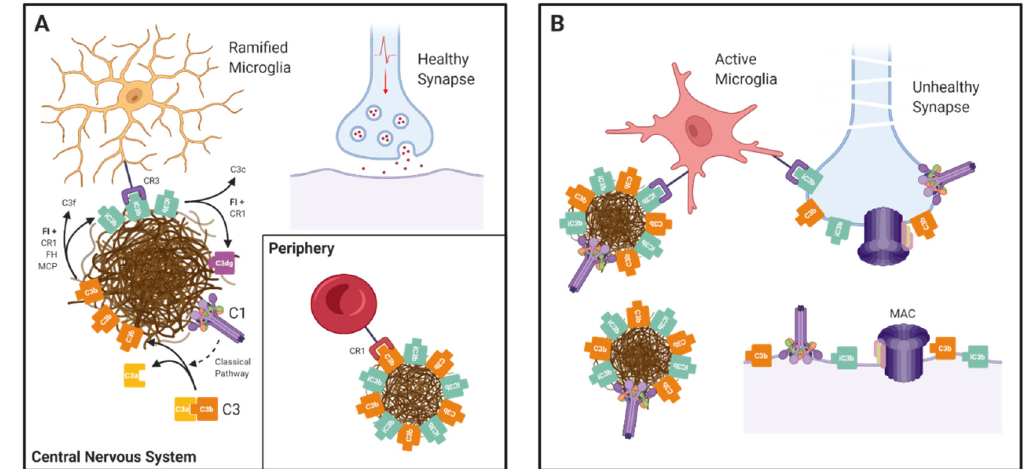
Figure 2. The Janus-faced nature of complement in AD: ( A ) In the central nervous system complement components and activation products (C1q/r/s and C3b) are deposited on amyloid plaques. C3b is converted to iC3b by Factor I (FI) with cofactor activity from CR1, Factor H, or MCP. iC3b binds to phagocytic receptor CR3 (an integrin dimer comprising CD11b and CD18 chains) on the surface of microglia, enabling plaque clearance. iC3b is further broken down by FI and CR1 into inactive C3dg. In the periphery, CR1 binds to C3b-opsonised amyloid aggregates and transports them to the liver for destruction in a process called “immune complex clearance”. ( B ) Complement dysregulation tips the balance towards destruction. In the absence of proper CR1 function, complement components accumulate, resulting in cell activation or damage. Complement is also involved in pathological synapse loss in AD. C1 binds to a poorly defined receptor on synapses and triggers classical pathway activation, resulting in C3b opsonisation and subsequent phagocytosis by activated microglia.